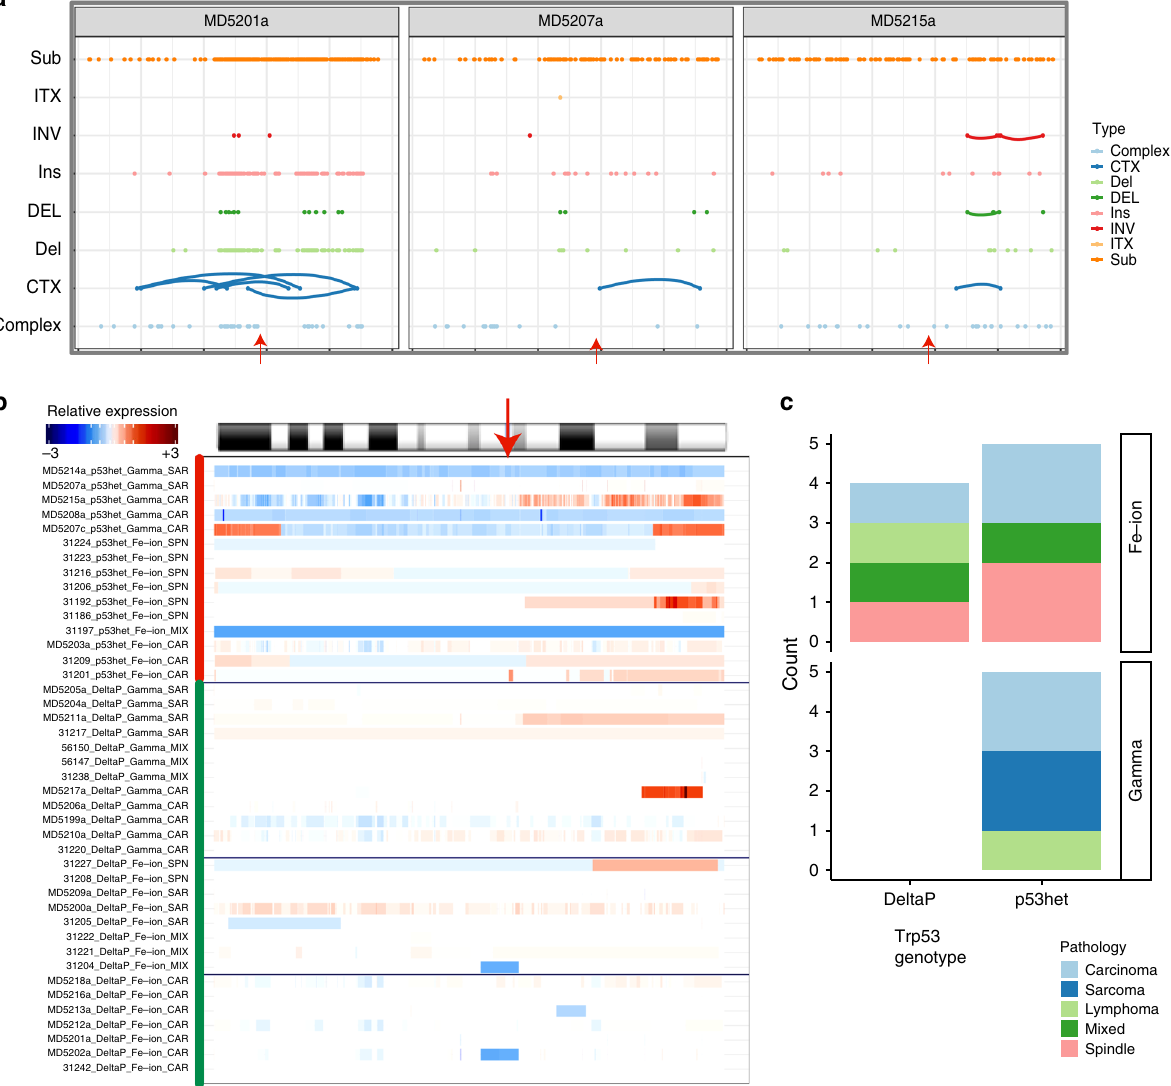
Fig. 7 Interaction between Trp53 genotype and RT quality in complex structural variants. a Three samples showing representative enrichment of SVs on chromosome 11 near the Trp53 locus, some with evidence of co-localisation of breakpoints and/or variants. Arrows denote the location of the Trp53 gene along chromosome 11. b Tumours from Trp53 + / − mice show common non-focal deletions or whole-chromosomal aneuploidy in chr 11 (top panel). These large scale copy number alterations are less common in tumours from the Trp53 Δ P mice (lower panels). Arrow denotes the location of Trp53 . c Effect of Trp53 germline genotype on patterns of somatic alterations at the Trp53 gene in mammary tumours. Trp53 deletions are frequently observed in animals of Trp53 heterozygous background exposed to either Fe ions or gamma radiation. In Trp53 Δ P mice, localised deletions at the Trp53 locus were only seen in tumours induced by 56 Fe